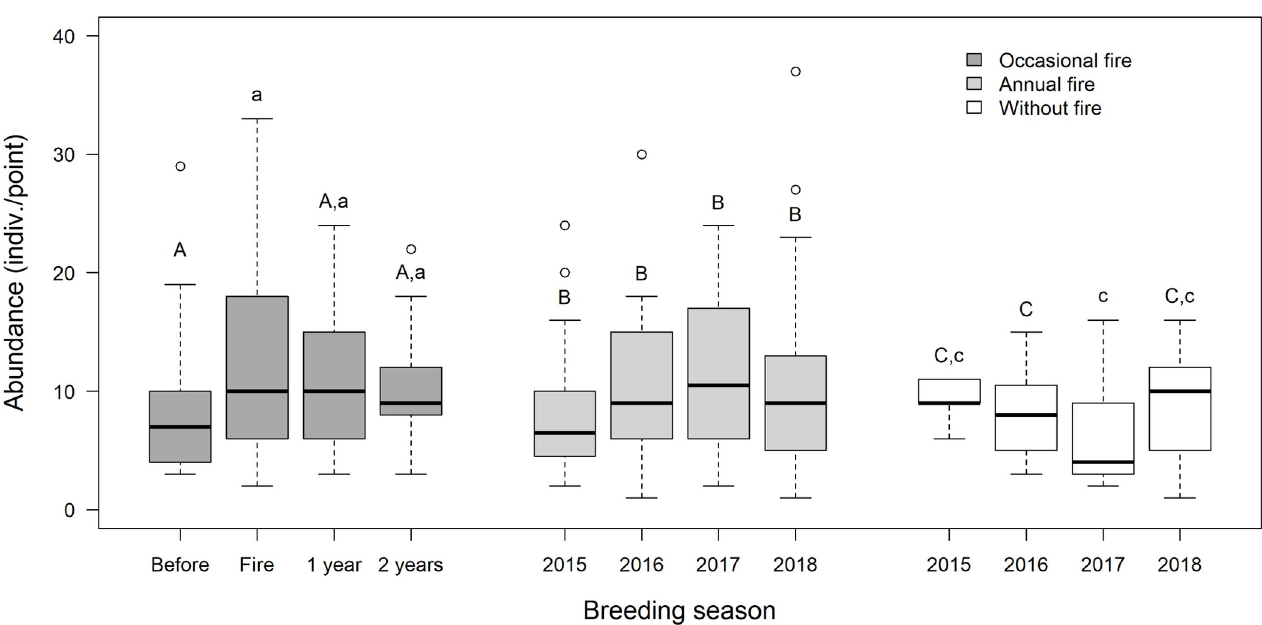
Fig 3. Abundance of birds recorded during four breeding seasons (2015–2018) in grasslands with three histories of fire disturbance in northeastern Rio Grande do Sul state, Brazil. In occasional fire breeding seasons refer to the year before the burn (before), in the year of the burn (fire), and one and two years post-fire (1 year and 2 years, respectively). Differences between letters in a same fire history (upper and lower case) indicate significant differences between breeding seasons, based on generalized linear mixed models. The line inside each box represents the median; top and bottom of each box represent upper and lower quartiles, respectively; whiskers represent maximum and minimum values; circles are